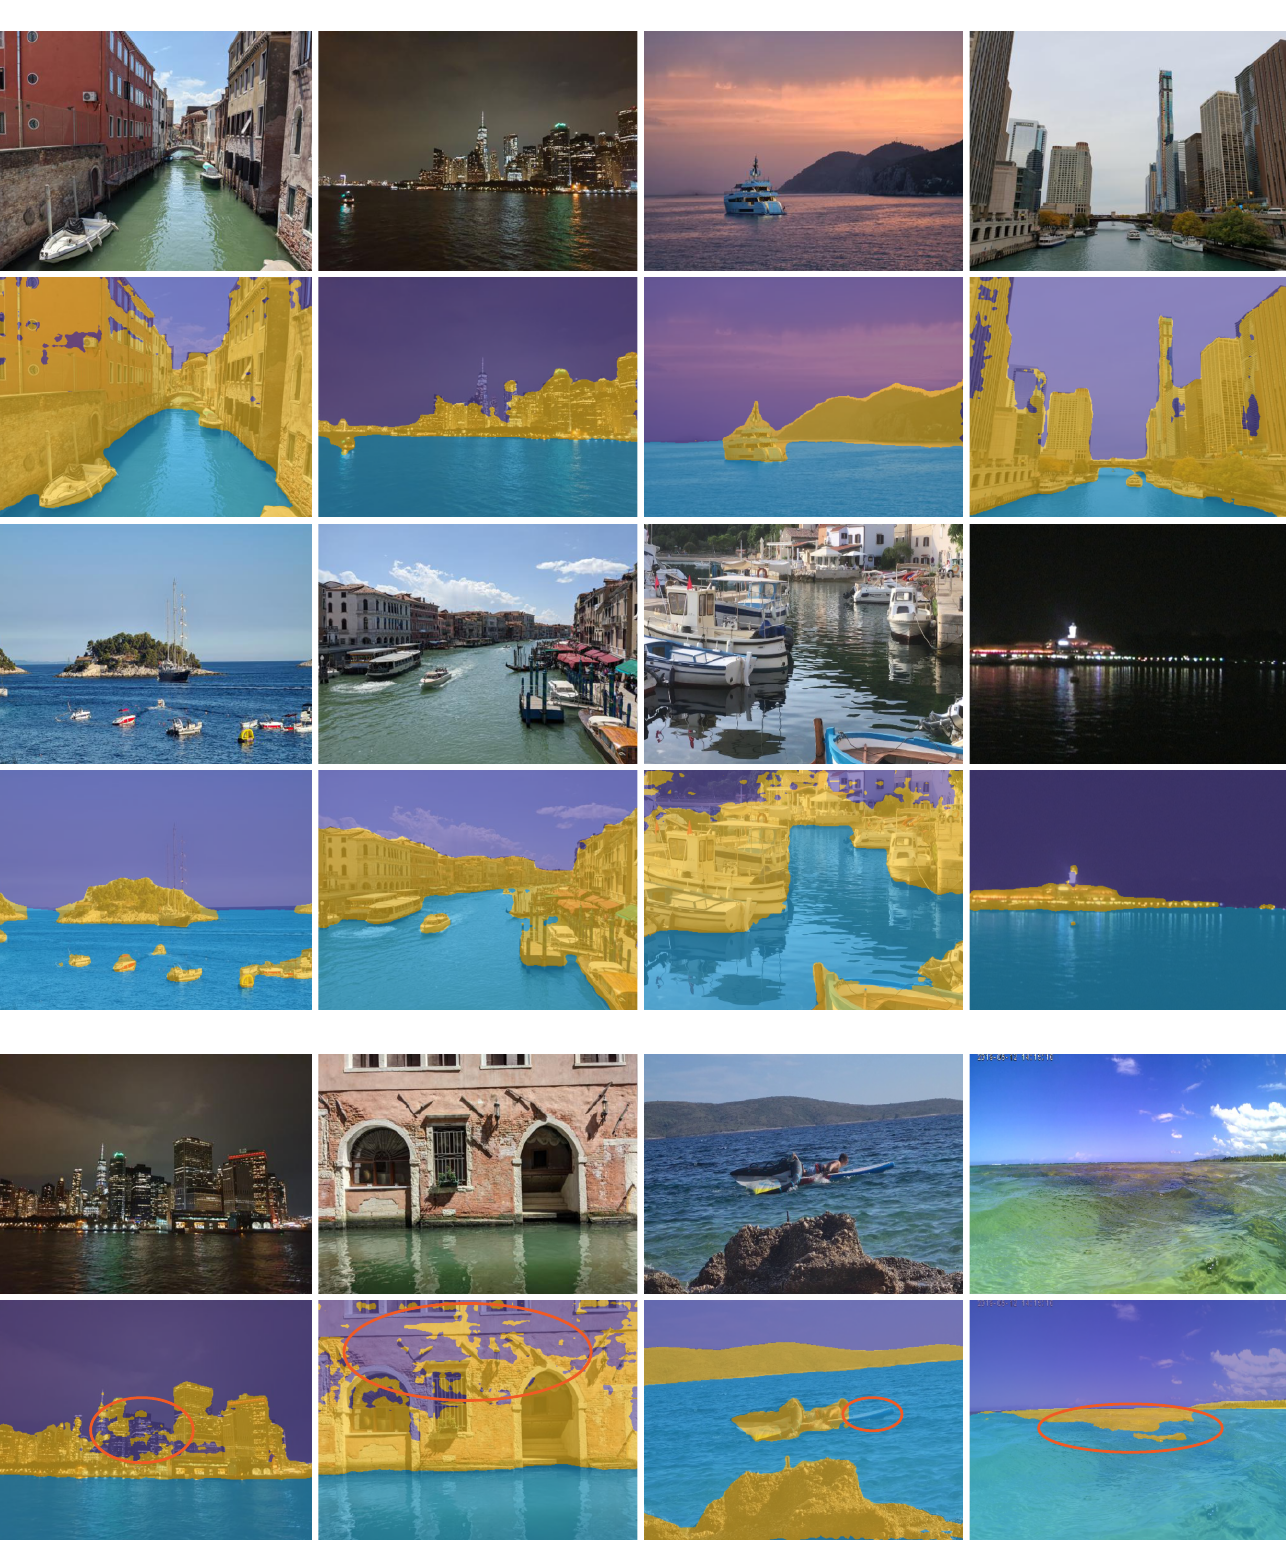
Figure 8. We observe strong performance of WaSR SLR in diverse maritime scenarios, including inland waters, different times of day and changes in water color. Failure cases are outlined in the last row and include sky hallucinations, partial detections of thin objects, and false detections of objects visible through the water. Orange circles highlight the areas where the segmentation is not